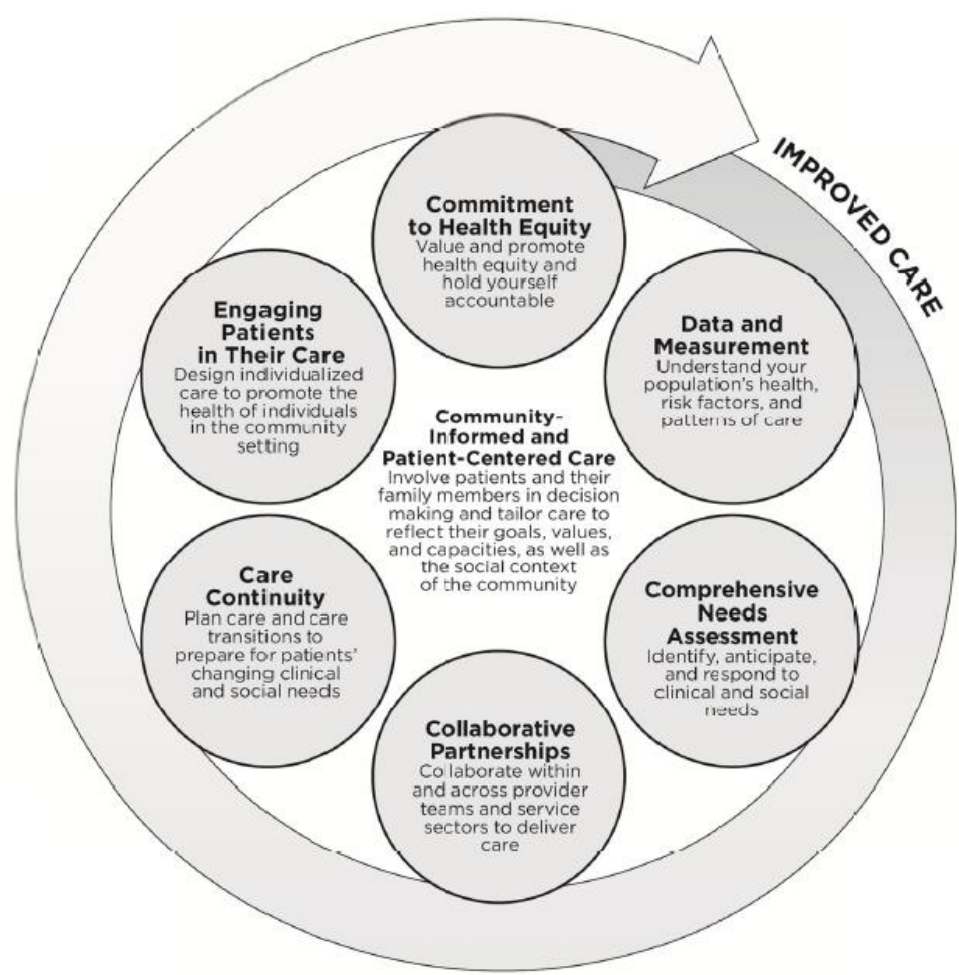
Figure 4.2: Systems